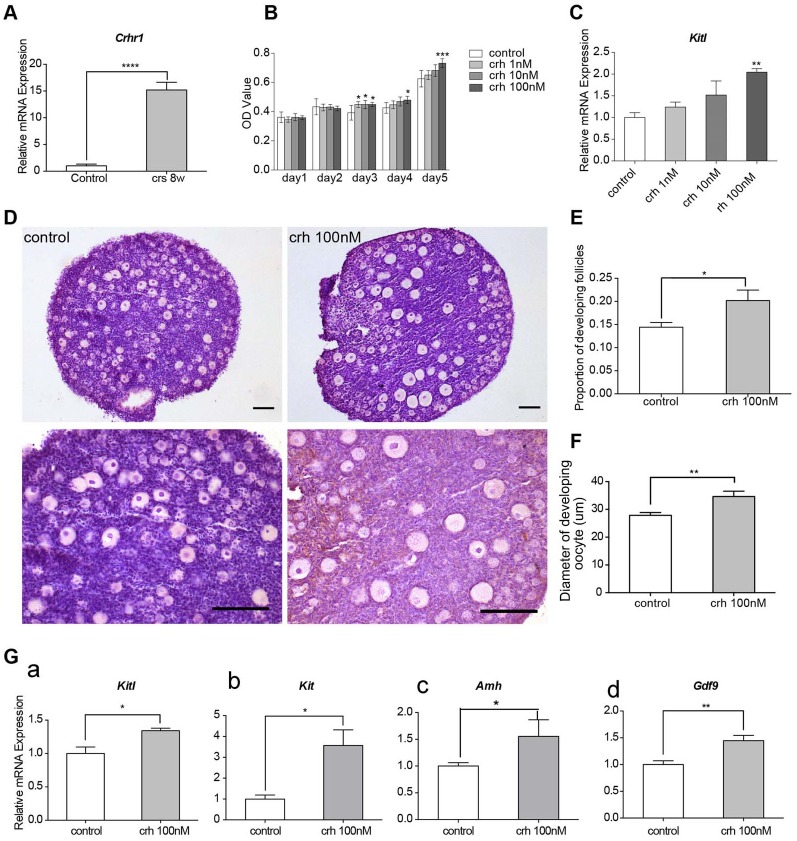
CRH triggers the activation of primordial follicles in the cultured ovaries of newborn mice in vitro.(A) The mRNA expression level of CRH receptor CRHR1 in the ovaries of the CRS group was significantly higher compared with that in the control group (n = 6). (B) The cell viability of mice granulosa cells (GCs) increased with the treatment of increasing concentration of CRH using theCCK-8 assay (n = 12). (C) The mRNA expression level of Kitl in mice GCs after culturing in serial concentration of CRH for 48 h (n = 6). (D) H&E staining of cultured mice ovaries from the control or CRH groups. Ovaries were isolated from the 3-day postnatal mice and cultured in vitro with or without CRH (100nM) for 7 days (scale bar, 100 μm). (E) CRH treatment increased the proportion of developing follicles in cultured mice ovaries (n = 6). (F) CRH treatment increased the diameter of oocytes in developing follicles in cultured mice ovaries (n = 6). (G) The mRNA levels of Kitl, Kit, AMH, and Gdf9 in cultured mice ovaries increased after CRH treatment (n = 6). (*P<0.05,**P< 0.01,***P< 0.001,****P< 0.0001).